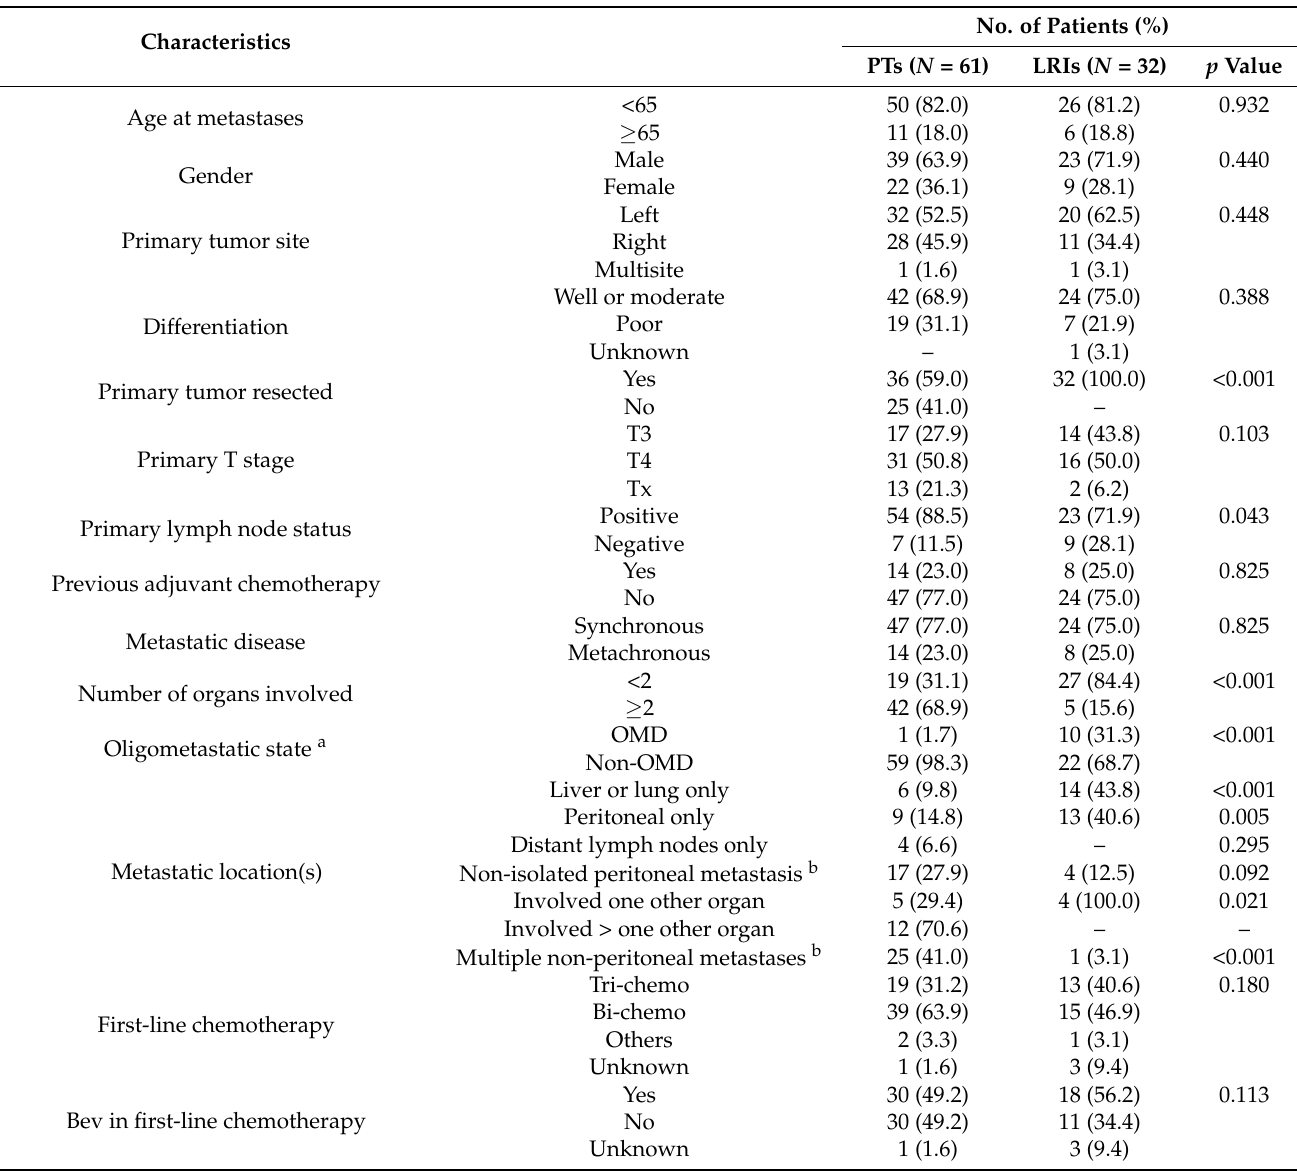
Table 3. Differences of clinical characteristics between treatment groups in BRAF V600E mCRC patients.